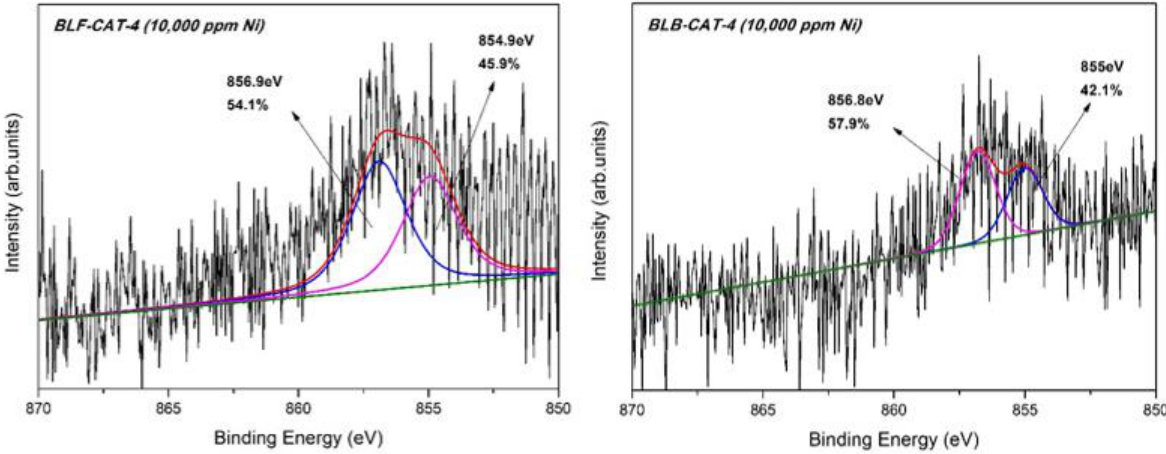
Figure 16. XPS spectra of the Ni 2p 3/2 region of Ni-loaded FCC catalysts: BLF-CAT-4 and BLB-CAT-4 (also containing boron) with 10,000 ppm Ni.